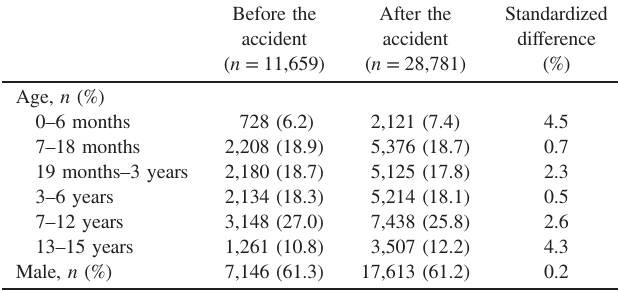
Table 1. Patient characteristics (2008 – 2013)